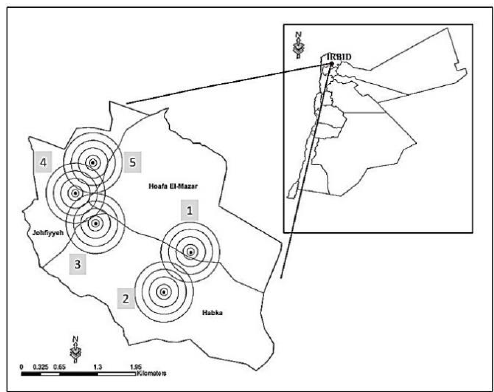
Figure 1. The geographical location. The area of the study is located in northern Jordan (city of Irbid). The amplified map showing the distribution of cellular stations with the tested (Hofa, Johfiah, and Habaka). Cell phone towers assigned by Arabic number (1 – 5).